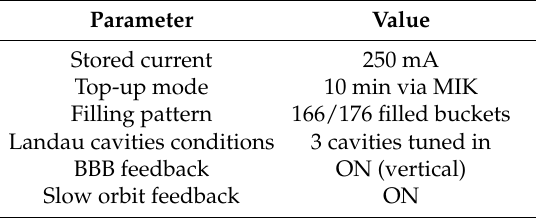
Table 3. Nominal operations conditions for the 3 GeV storage